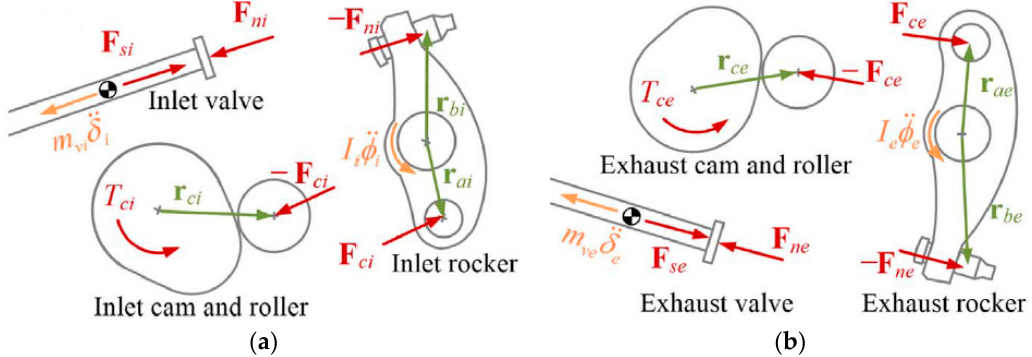
Figure 16. Free-body diagram (FBD) of the valve, rocker, cam, and roller of the engine camshaft at: ( a ) inlet; ( b ) exhaust [34]. Figures are reprinted with permission from publisher. Table 2. Notations used in derivation of the force and moment equations for the camshaft